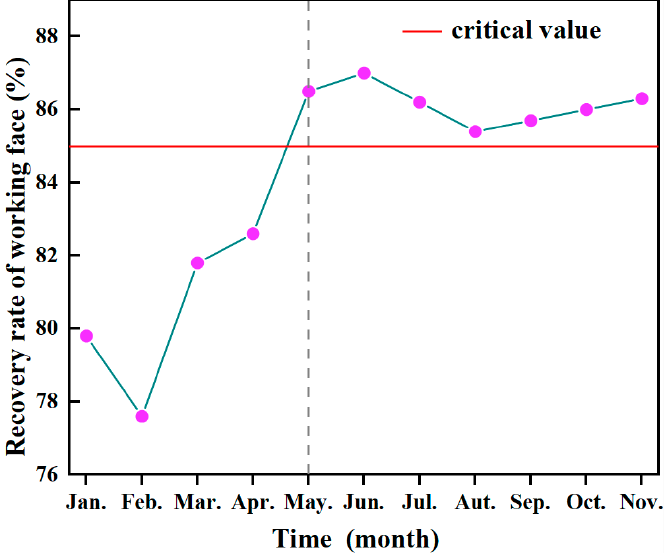
Figure 18. Working face 42,108 recovery rate curve graph.